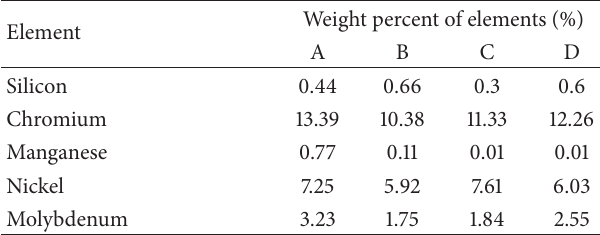
Figure 8: The tensile tests curves for EBW full penetration weld samples. Table 6: The EDS analyses from subgrain boundary and subgrain spaces in the weld zone (sample number 3).